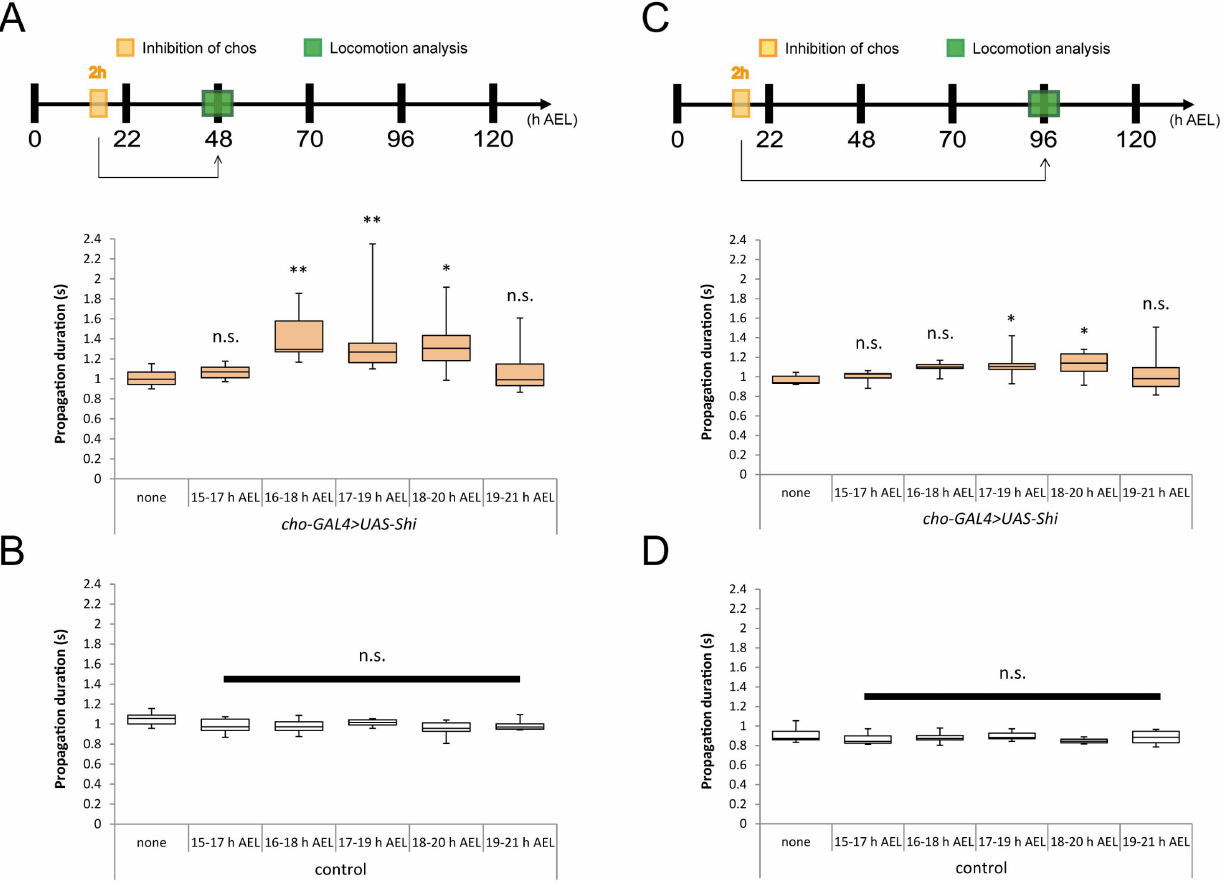
Figure 5. A critical period for the maturation of the sensorimotor circuit. (A, C) The effects of temporal inhibition of chos neurons at various embryonic stages on larval locomotion, analyzed at the second (A, 48 h AEL) and third instar (C, 96 h AEL) stage. A two-hour temperature shift to a restricted temperature was applied to iav-GAL4 . UAS-Shi ts embryos at various stages during embryogenesis. The temperature shift at specific embryonic periods increased the propagation duration. (B, D) The same temperature shift applied to control embryos ( yw . UAS-Shi ts ) had no effect on locomotion, when analyzed at the second (B) and third instar (D) stage. Statistical significance was determined by one-way ANOVA followed by Dunnett’s test for multiple comparisons (**P , 0.01; *P , 0.05; n.s., not significant compared with iav-GAL4 . UAS-Shi ts (none) control). For all conditions, n=10. RT, restrictive temperature.